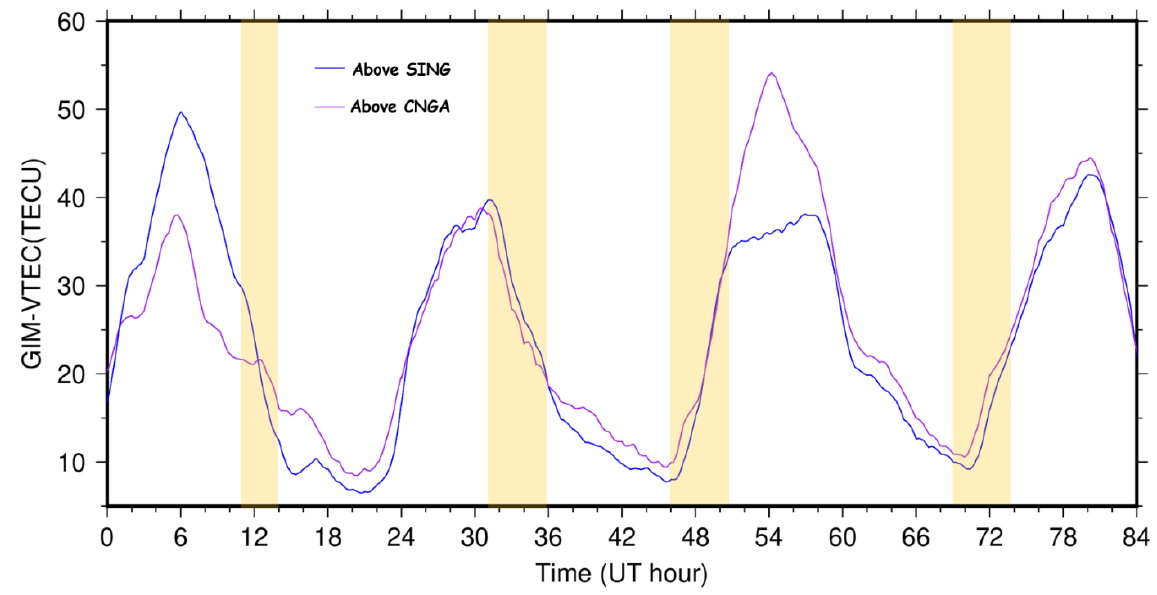
Figure A3. VTEC from GIM above stations in Java (CNGA, purple) and around Sumatra (SING, blue), including the LW passage times indicated as yellow bands over three and a half consecutive days after the HTHH eruption on January 15. Horizontal axis shows time in hours counted from 0 UT of 15 January.